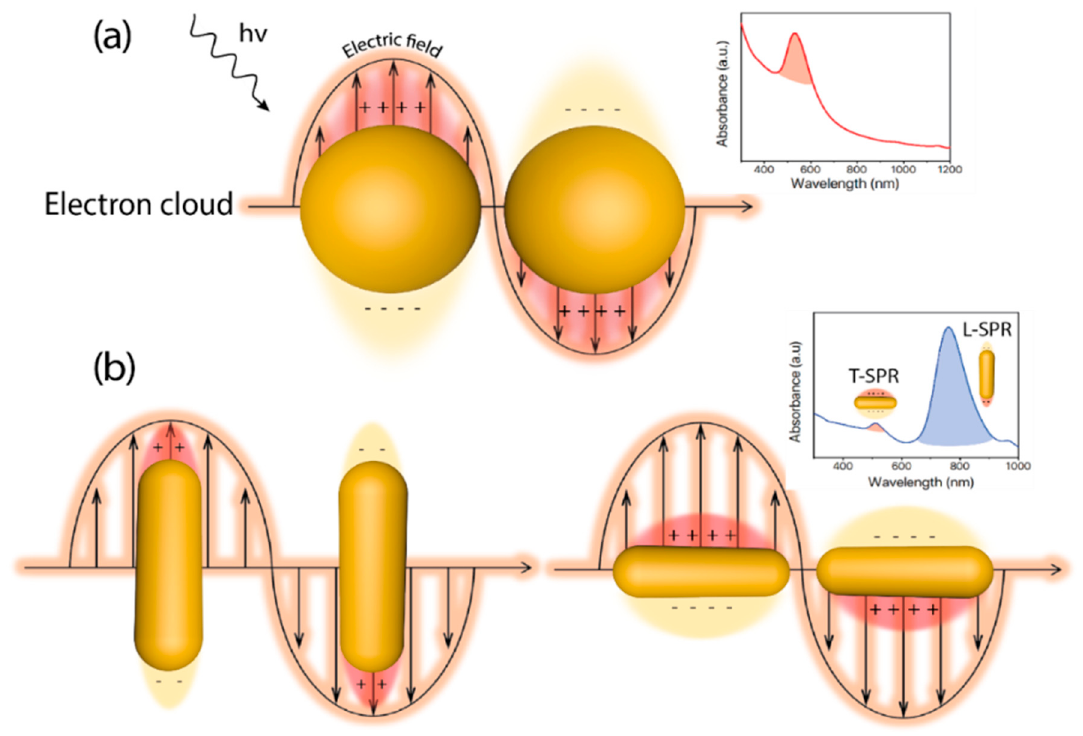
Figure 1. Morphology of the plasmonic nanostructure determines its Localized Surface Plasmon Resonance (LSPR). ( a ) Isotropic Au nanoparticles (AuNPs) possess confined electrons alike in all directions, resulting in a single LSPR band in the visible range; ( b ) the introduction of morphological anisotropy allows LSPR with different absorption maxima. For the particular case of nanorods (AuNR), the longitudinal induced anisotropy entails an LSPR at the near-infrared (NIR) window as the confinement of electrons is different at the AuNR edges or sides.